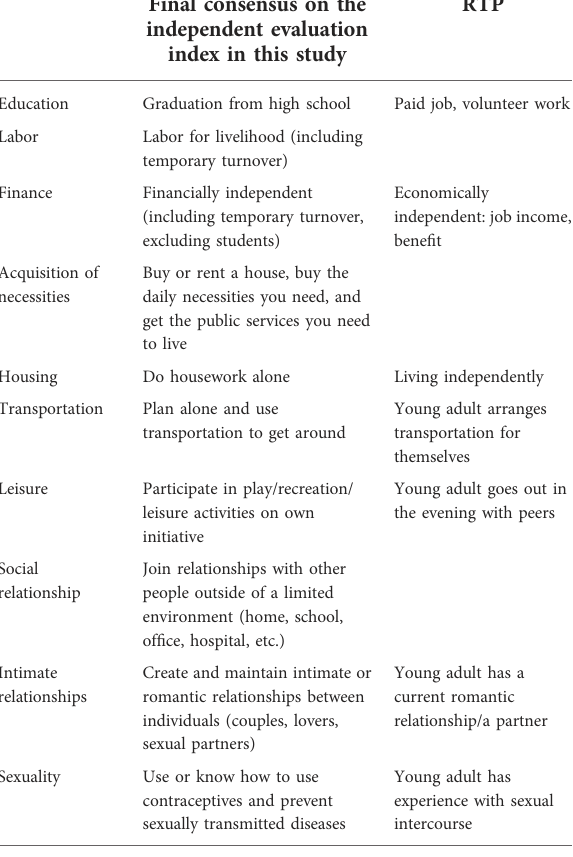
TABLE 3 A comparison of the independent evaluation index established in this study and the